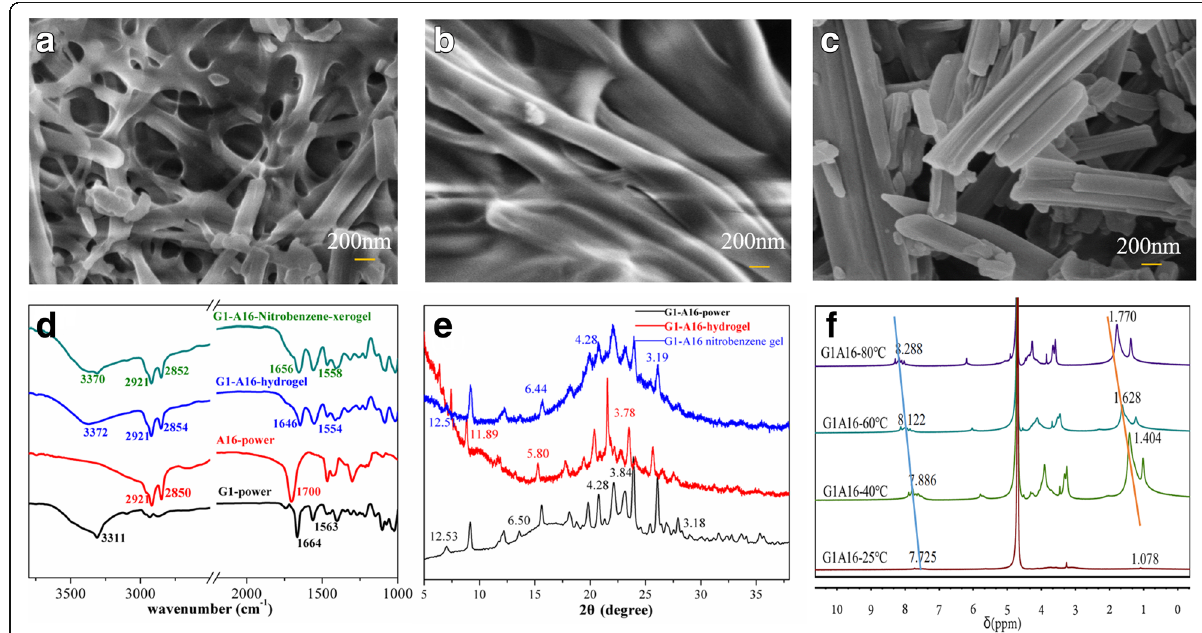
Fig. 5 a SEM image of xerogels prepared by G1-A16 nitrobenzene gel. b SEM image of xerogels prepared by G1-A16 hydrogel. c SEM image of G1 power. d FT-IR spectra of G1-A16 from chlorobenzene xerogel, hydrogel (2.0% w / v ), A16 power and G1 power. e X-ray diffraction pattern of the xerogel of G1-A16 from chlorobenzene xerogel, hydrogel (2.0% w / v ). f G1-A16 power, 1 H NMR spectra of G1-A16 (2.0% w / v ) in D 2 O at different